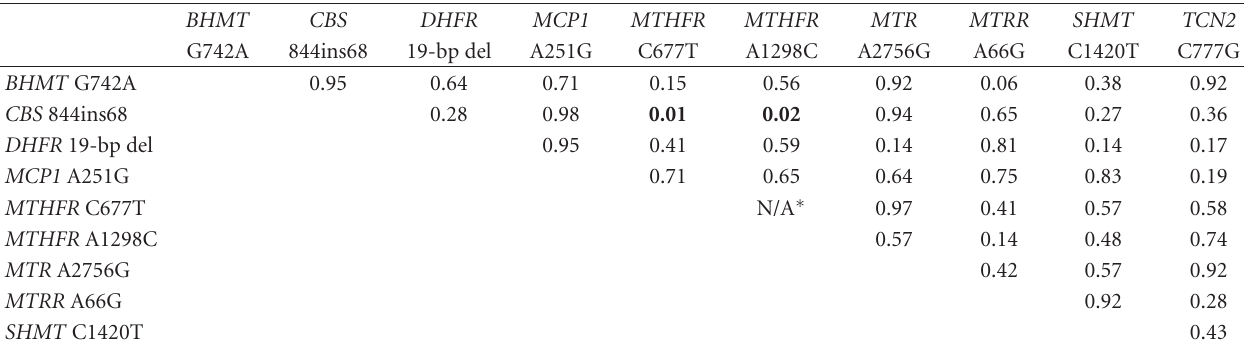
Table 3: Case-only results (unadjusted P values) for all pairwise combinations of maternal genotypes and CTRD, Children’s Hospital of Philadelphia, 1997–2007. BHMT